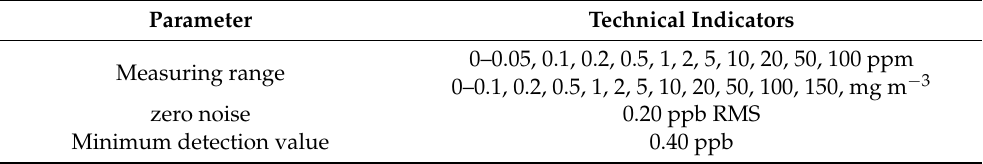
Table A3. Main technical